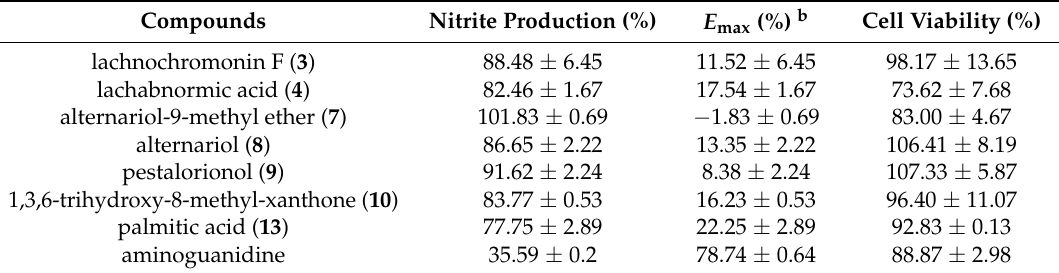
Table 2. Inhibitory effects of the seven isolates from L . abnorme on LPS-activated NO production in RAW 264.7 macrophages a